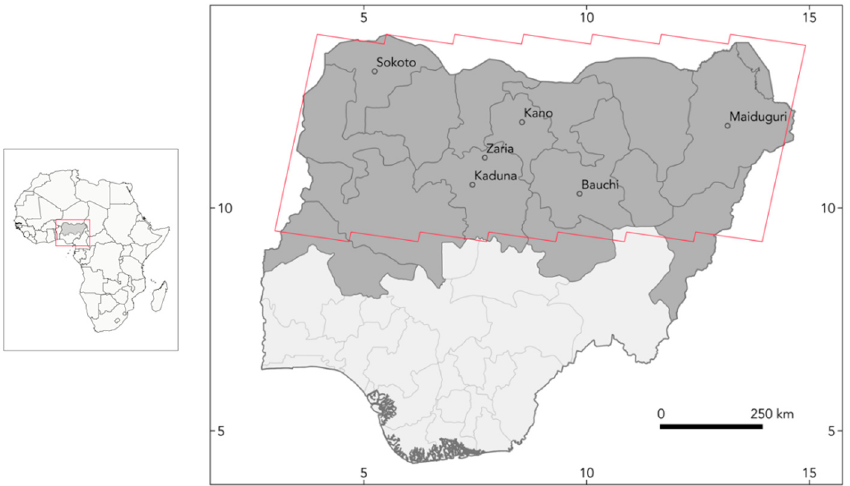
Figure 1. States included in this work (dark grey) and of Landsat scenes used in the study (red line).